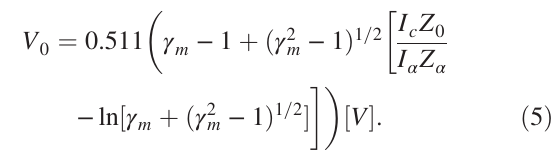
FIG. 4. Electron density contours in the ∅ 31 cm convolute [Fig. 3(a)] during the pulse rise. Arrows mark the locations in each outer MITL where Eq. (5) is compared to the simulation voltage in Fig.